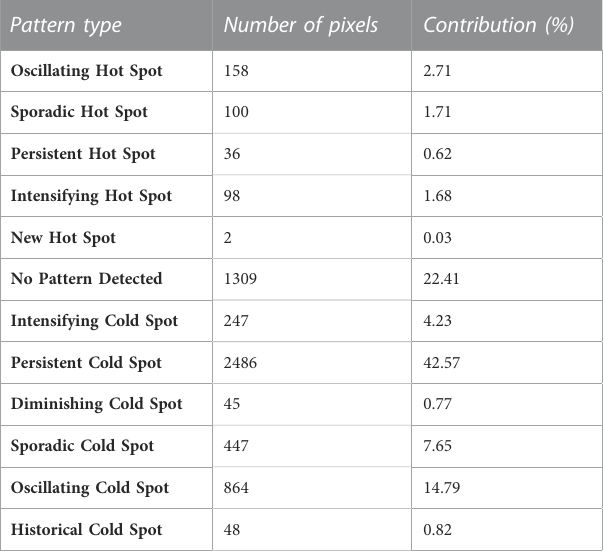
TABLE 2 Emerging hot-spot analysis: pixels